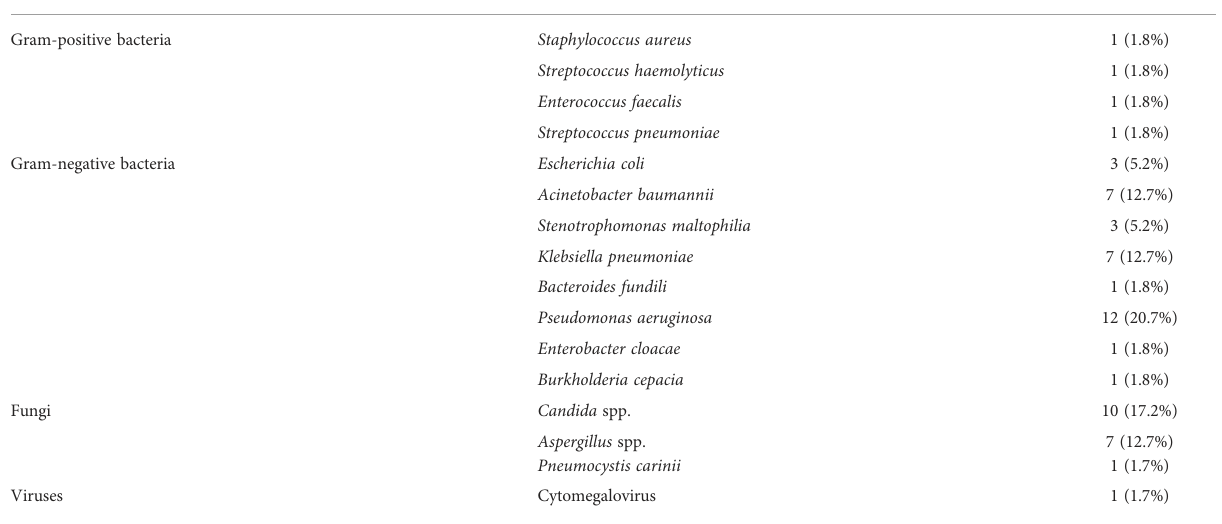
TABLE 2 Microbiologically con fi rmed